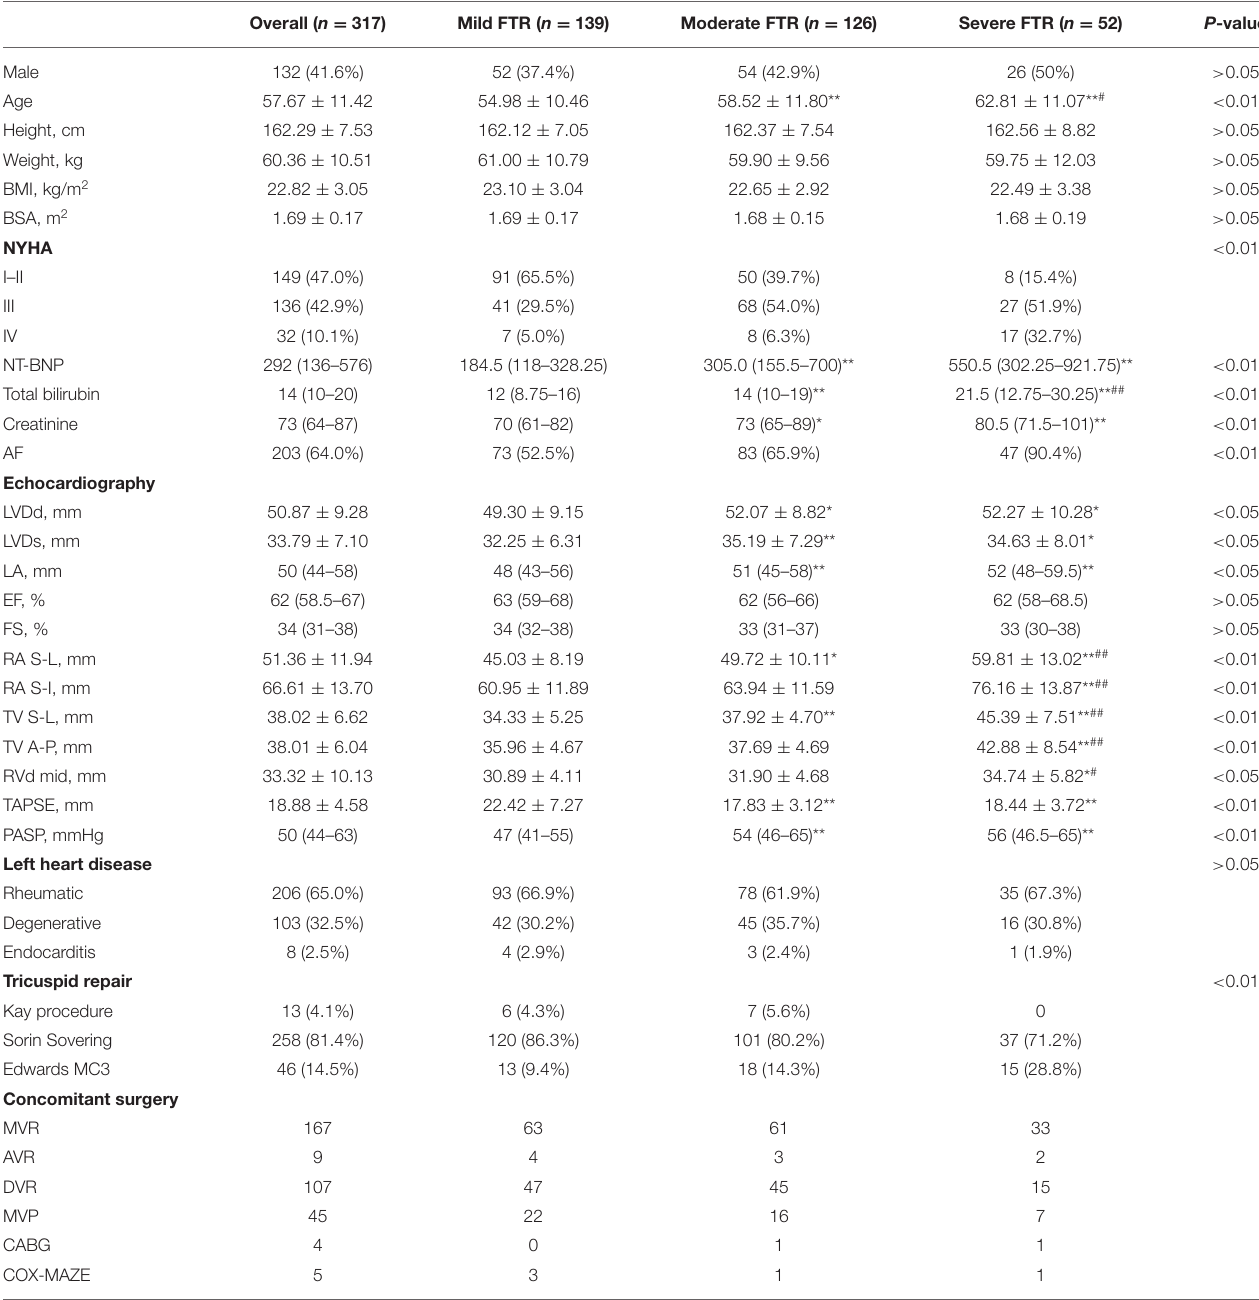
TABLE 1 | Preoperative and operative